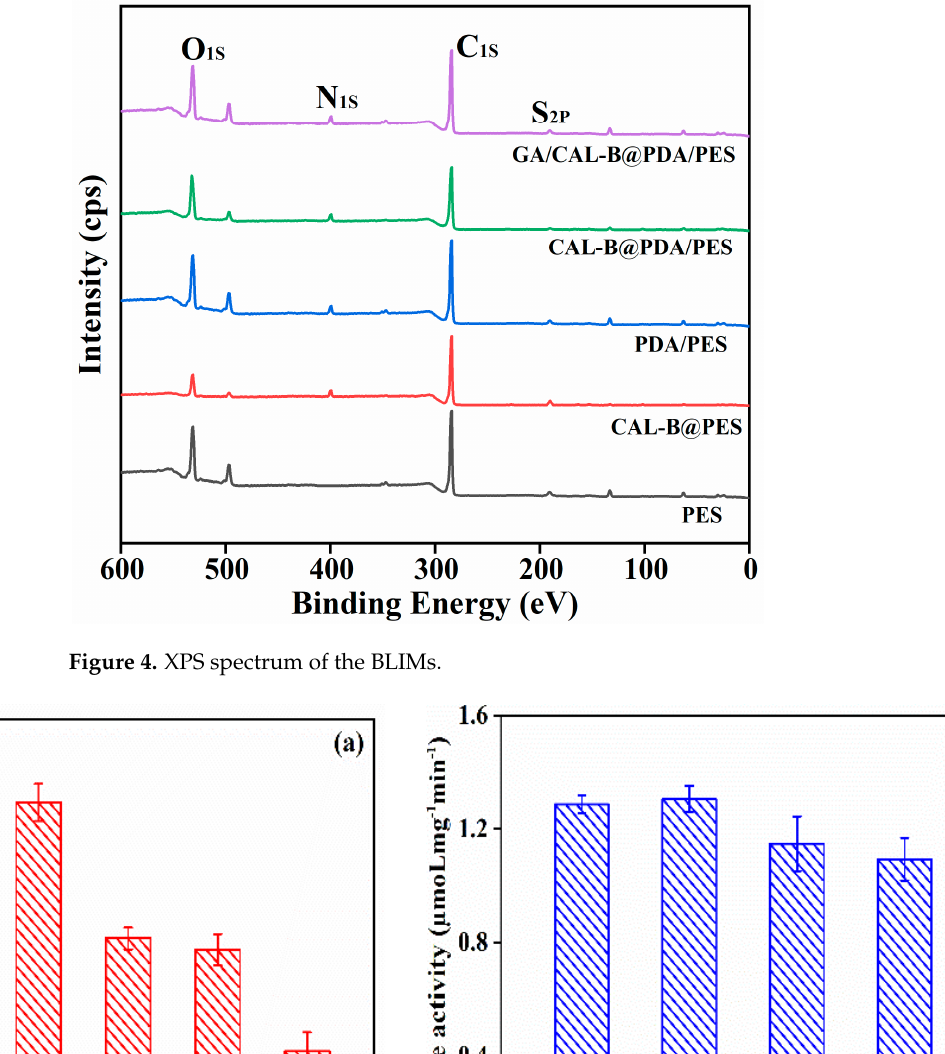
Figure 4. XPS spectrum of the BLIMs.